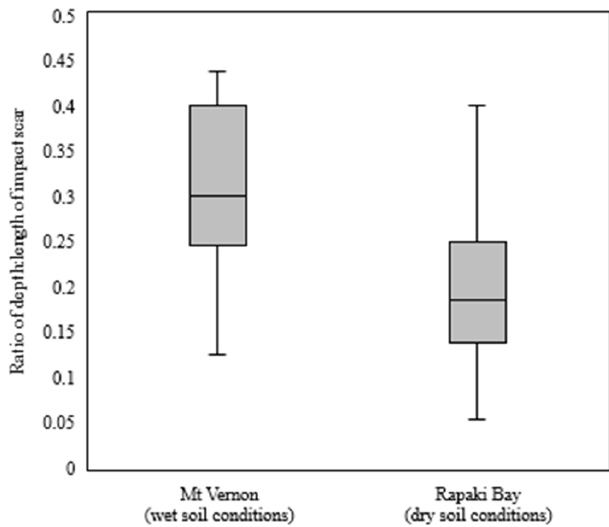
Figure 5. Depth vs. length of impact scars measured at Rapaki Bay ( n = 140) in dry soil conditions and Mt Vernon ( n = 19) in wet soil conditions. P = 0 .